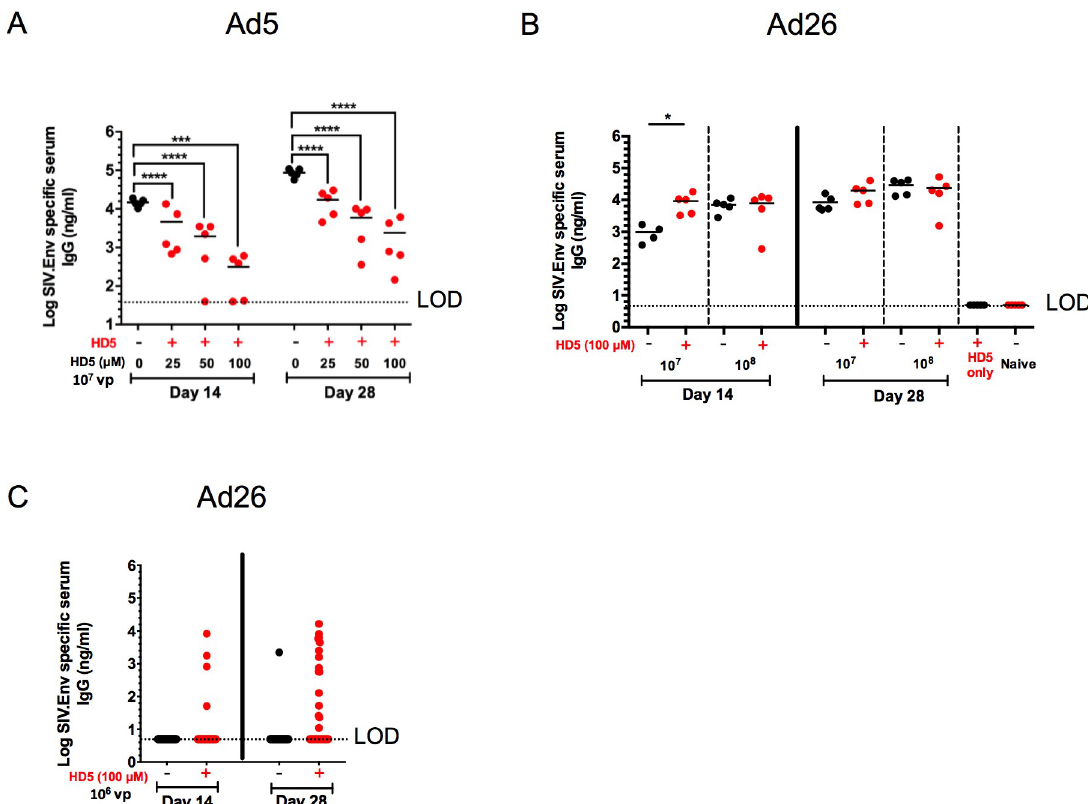
Fig 5. Vaccine-elicited antibody responses to Ad5 and Ad26 ± HD5 pretreatment. C57BL/6 mice (n = 5/group) were pretreated with either PBS or a dose titration of 25 μ M– 100 μ M HD5 with (A) Ad5.SIVEnv (10 9 vp) or 100 μ M HD5 with (B) Ad26.SIVEnv (10 8 –10 7 vp) encoding SIV ENV. Env-specific IgG responses were determined in serum by ELISA at days 14 and 28 post immunization. Means and standard deviations of endpoint ELISA titers are shown. ��� p < 0.001, �� p < 0.01, � p < 0.05, one-way ANOVA test (compared to virus only control). (C) 35 animals/group immunized with Ad26.SIVEnv (10 6 vp) with and without 100 μ M HD5 on Day 14 and 28 post immunization. Groups (Ad26-HD5 compared to Ad26) were assessed for significance on day 14 or day 28 using a Fisher Exact Test to identify nonrandom associations between groups. The day 28 analysis resulted in a two-tailed Fisher Exact Test p value = 0.0017. The data are representative of experiments performed three times.